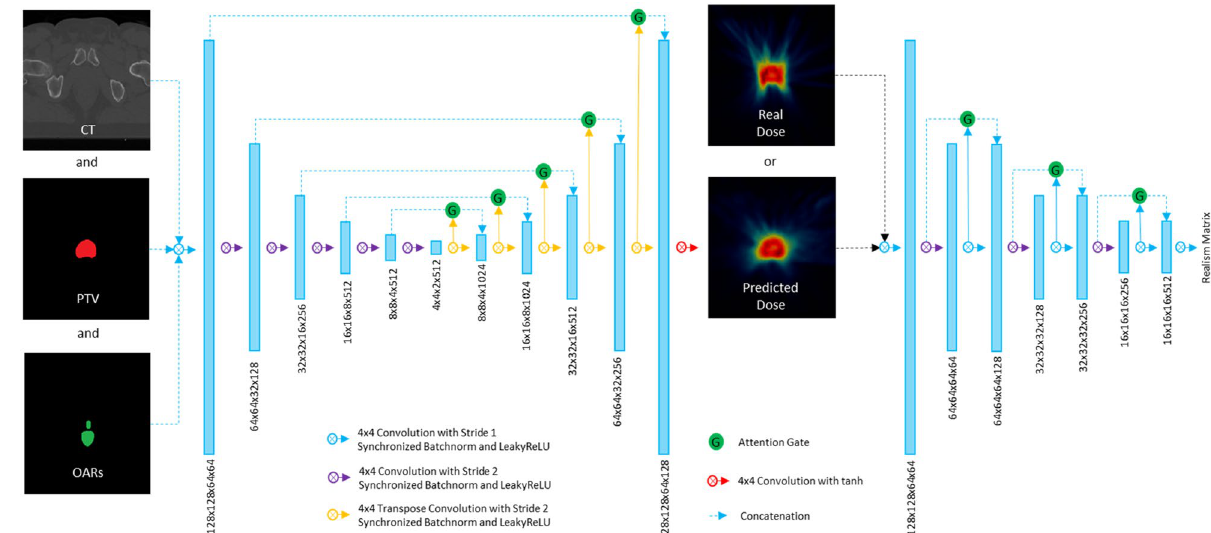
Figure 2. The generator network (left) and discriminator network (right) are shown. The CT, PTV, and OARs are concatenated and fed into the generator network. The discriminator network predicts a realism matrix that attempts to decipher synthetic dose predictions from real dose